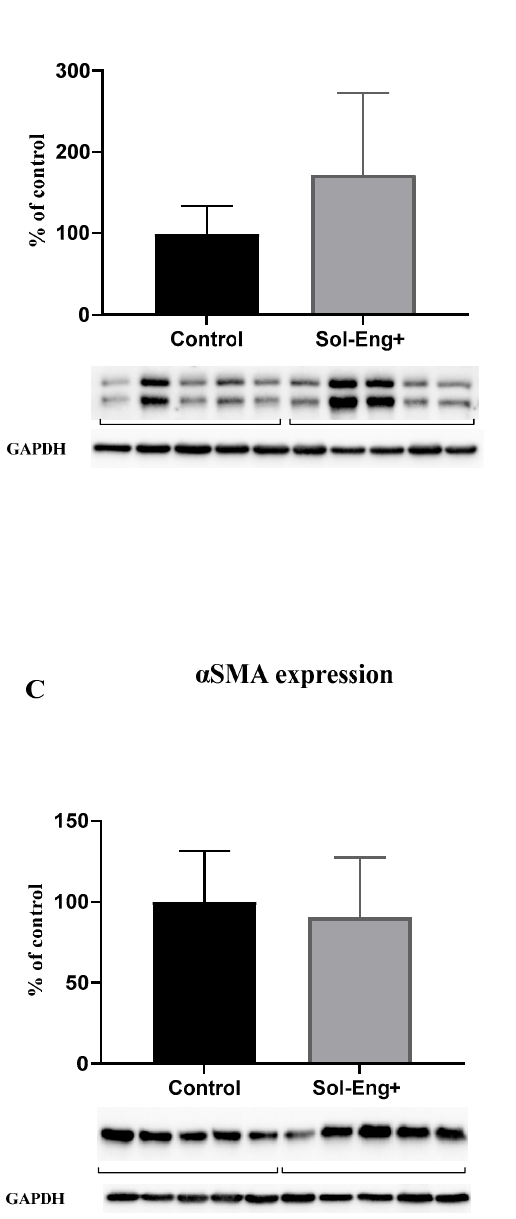
Figure 5. Expression of markers related to smooth muscle cell reactivity. Expression of MLCK ( A ), p-MLCK ( B ), and α SMA ( C ) in total protein extract from mice aortas. Densitometric quantification of immunoreactive bands (top panel: densitometric analysis, control = 100%) was recalculated to the GAPDH signal (bottom panel: representative immunoblots). Data are shown as mean ± S.E.M, Mann–Whitney test. n = 5 mice per group.